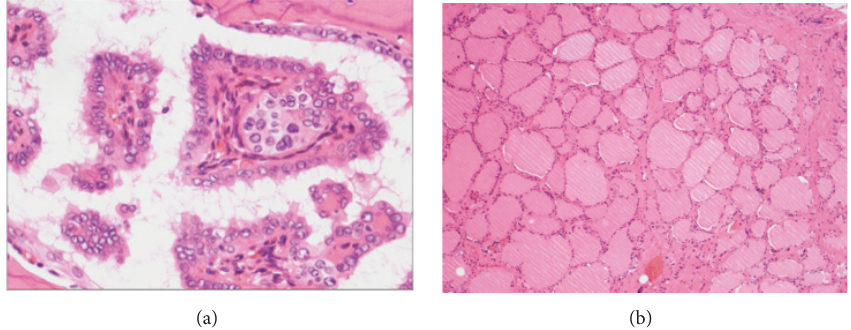
Figure 3: Histopathological finding of the hyoid bone tumor. (a) Microscopically, the tumor comprises atypical cell forming papillae, corresponding to thyroid papillary carcinoma. (b) Thyroid follicles are also seen around the malignant component [hematoxylin-eosin staining; magnification: 400 × (a), 100 ×